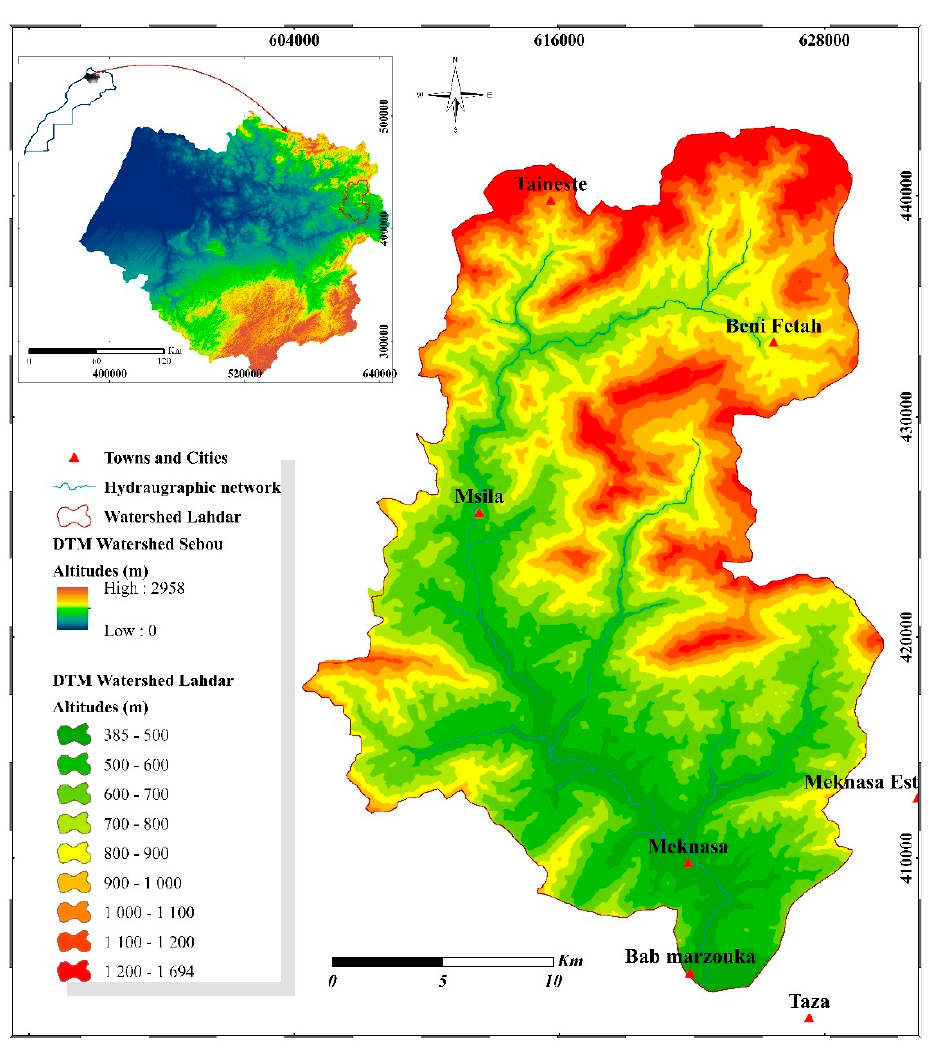
Figure 1. The geographic situation of the Study Area. Oued Lahdar originates in the mountains of the Outer Rif, in the northern part of Oued Inaouene. The watershed of Oued Lahdar extends over the Outer Rif, which